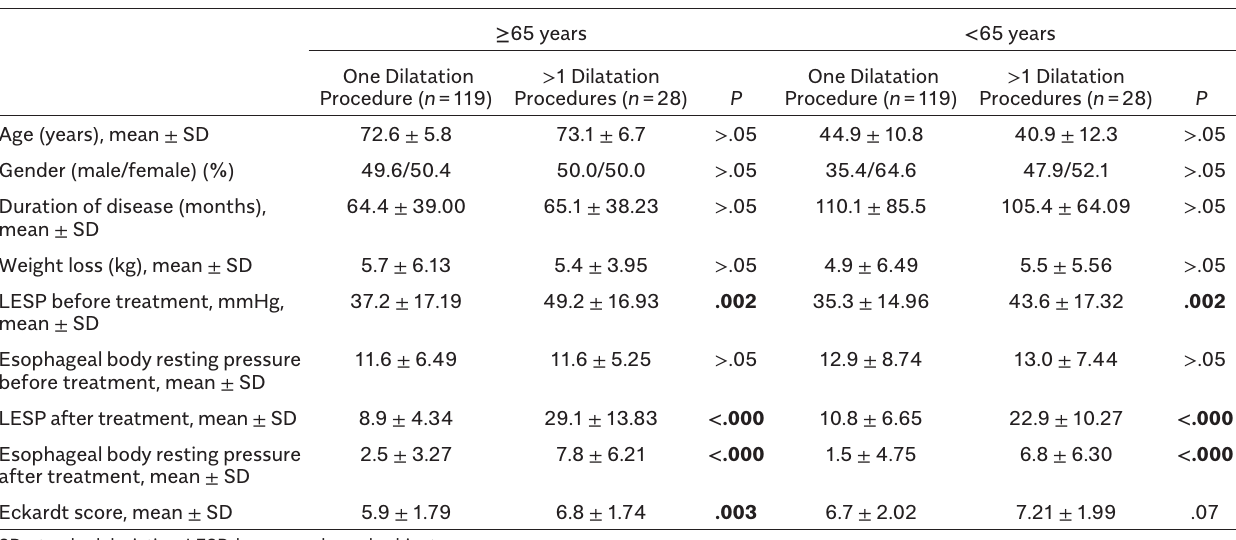
Table 3. Comparison of Remission After Single Dilatation and Multiple Dilatations ≥ 65 years < 65 years One Dilatation Procedure ( n =